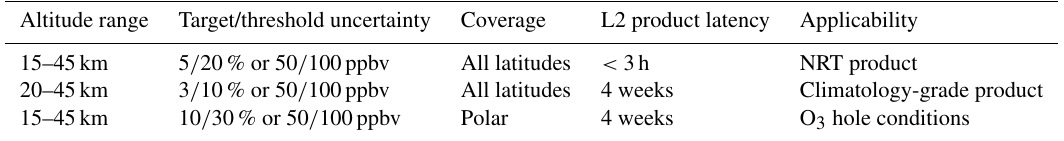
Table 1. ALTIUS primary scientific objective requirements for O 3 profiles. For the product uncertainty, the least stringent value of the relative or absolute uncertainty specifications shall apply. In the second column, “target” denotes the desired performance and “threshold” denotes the minimum satisfactory performance.